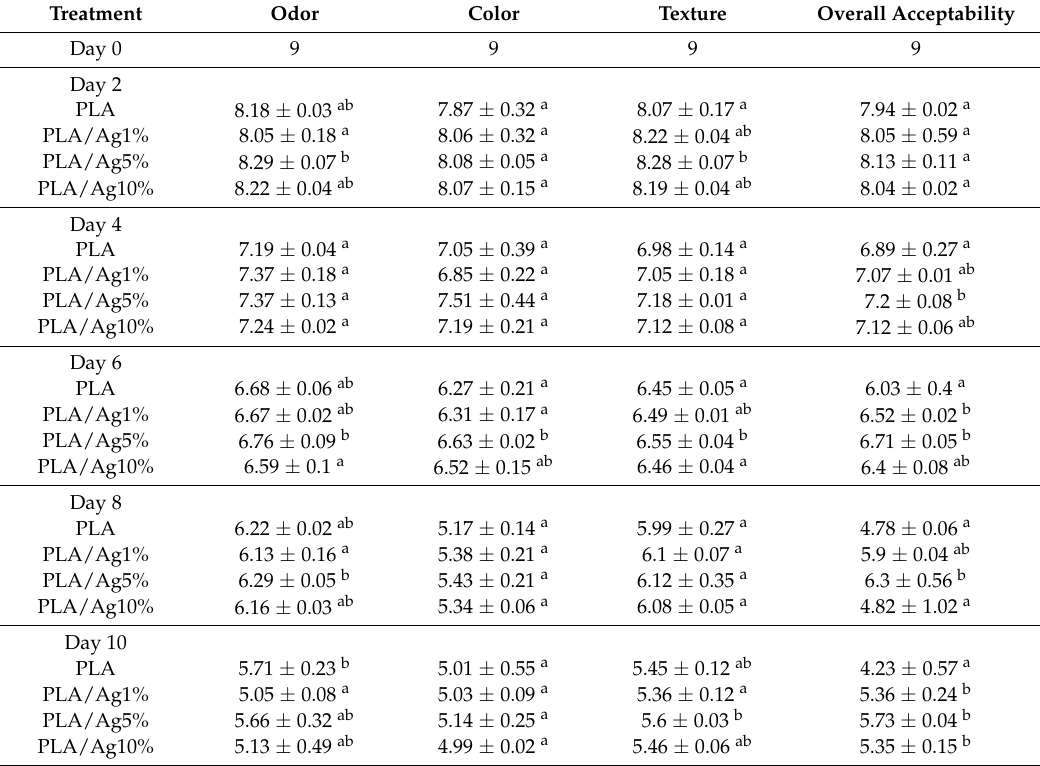
Table 1. Sensory evaluation of strawberries stored for 10 days at 4 ± 1 ◦ C in different concentration of nano-Ag active